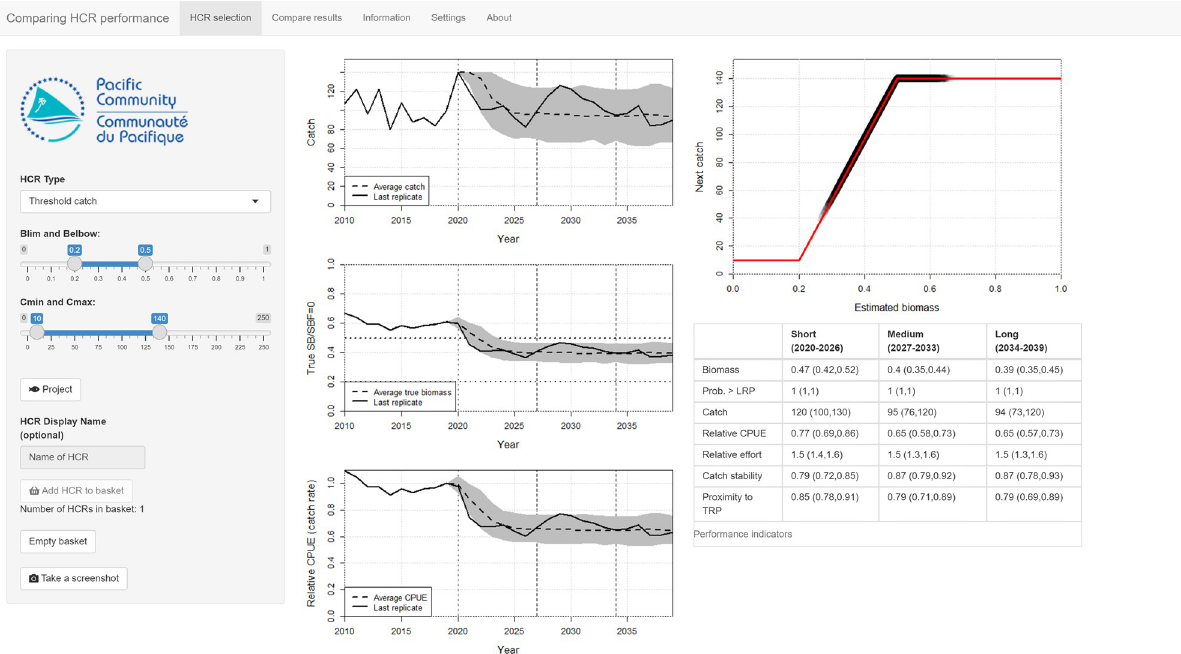
Fig 4. A screenshot of the main page of the Comparing performance app. The controls that set the shape of the HCR and run the projections are in the left-hand panel. In this example, the Project button has already been pressed to run a projection with multiple replicates. Biological variability is switched on by default. The results are shown in the time series plots. The grey ribbon shows the 90th percentile range, the dashed line is the median value across the replicates and the solid line shows the last replicate as an illustration. The performance indicators are shown in the table underneath the HCR plot. If users are happy with the results they can add the HCR to the basket of candidate HCRs by pressing the Add HCR to basket button.